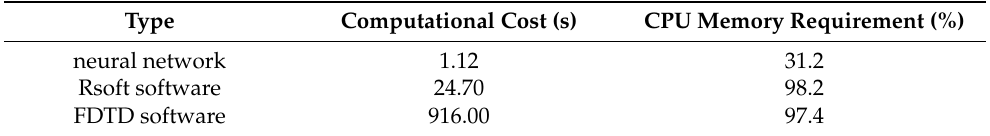
Table 6. Performance comparison of the series feedback neural network 1 .